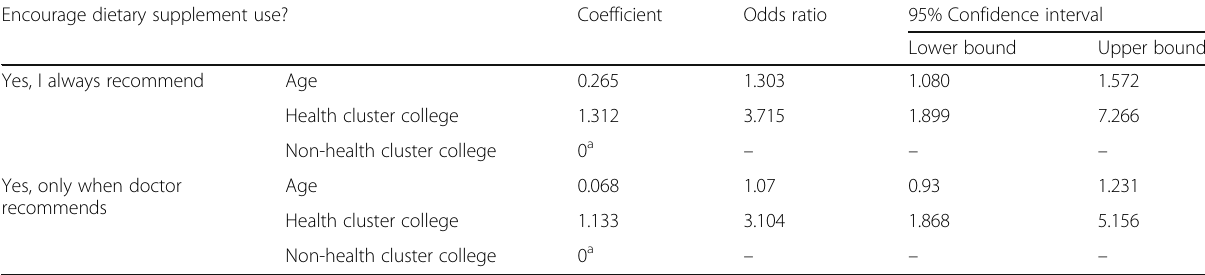
Table 6 Multinomial logistic regression analysis Encourage dietary supplement